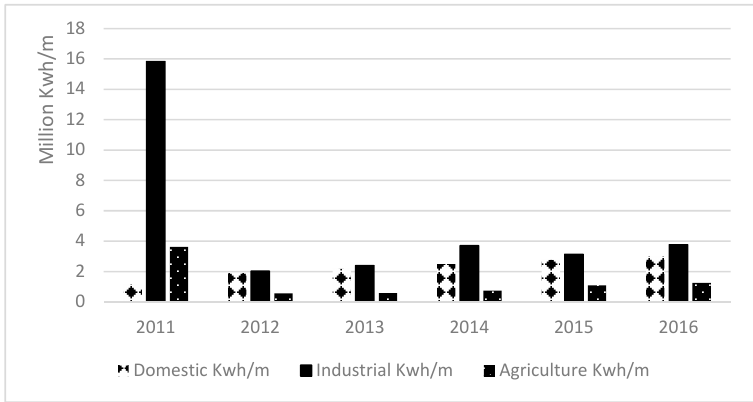
Figure 5. River Nile State electricity use in million KWh (2011–2016). Source: Sudanese Electricity Distribution Ltd 2017.